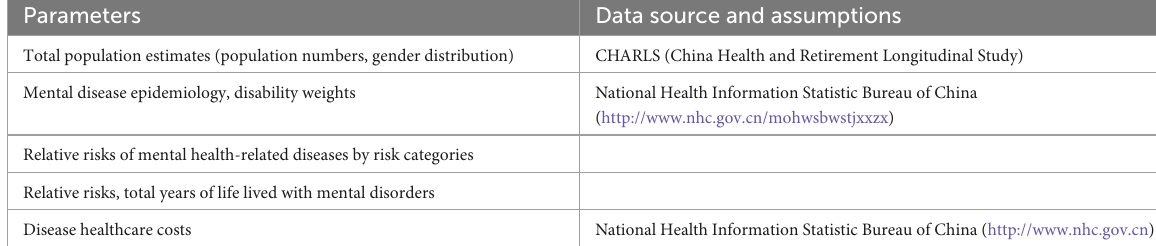
TABLE 4 Input parameters for health impact modeling.